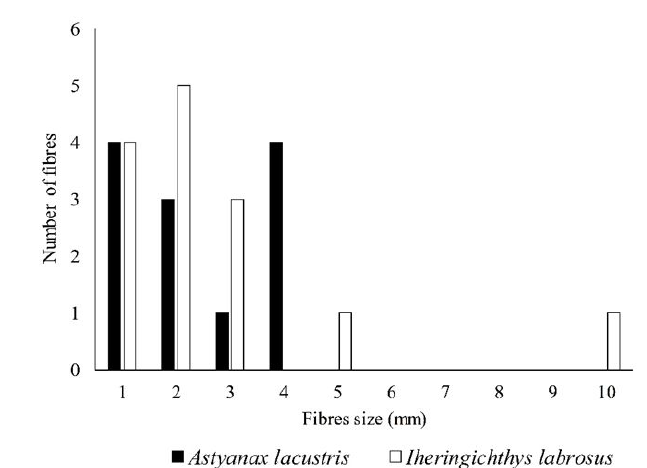
Figure 2. Microplastics found in stomach contents, left to right: white fragment under the microscope with direct light, blue fibre with direct light and the same fibre with polarized light showing birefringence behavior.